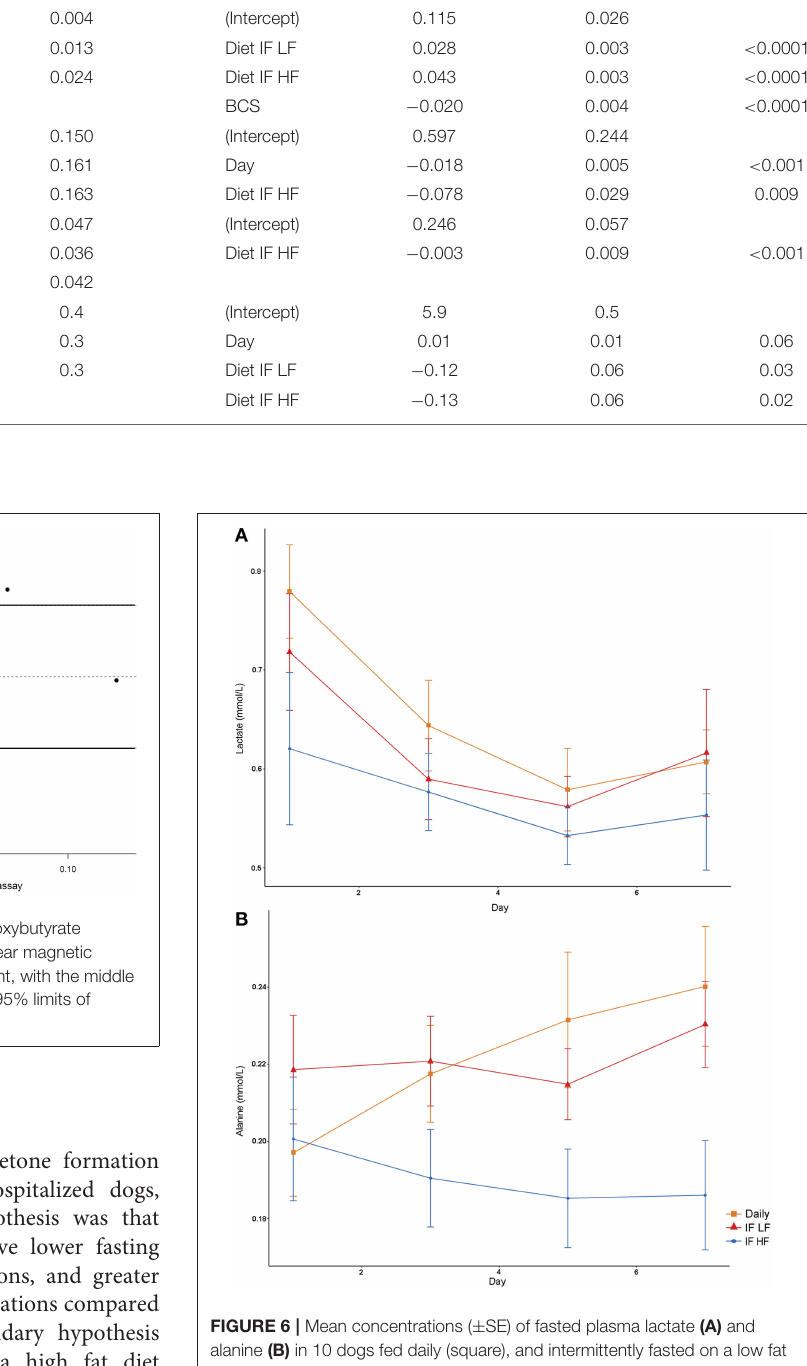
concentrations, and lower insulin concentrations than when they were fed daily or fasted on a LF diet. Leptin was not maintained during intermittent fasting by using a HF diet; however, there